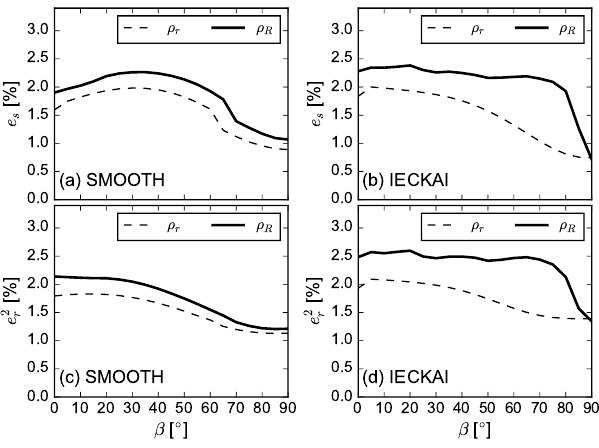
Figure 4. The relative systematic error ( e s ) and random error vari- (cid:16) (cid:17) e 2 r ance derived from the autocorrelation functions of the sim- ulated point radial velocity ( ρ r ) and averaged radial velocity ( ρ R ) from the SMOOTH model in (a) and (c) and from the IECKAI model in (b) and (d) (TurbSim) as functions of the angle between the LOS and mean wind direction ( β ). The sampling duration is 100 τ 0 , where τ 0 is the first time when the point radial velocity au- tocorrelation crosses 1 /e at β = 0 ◦ .